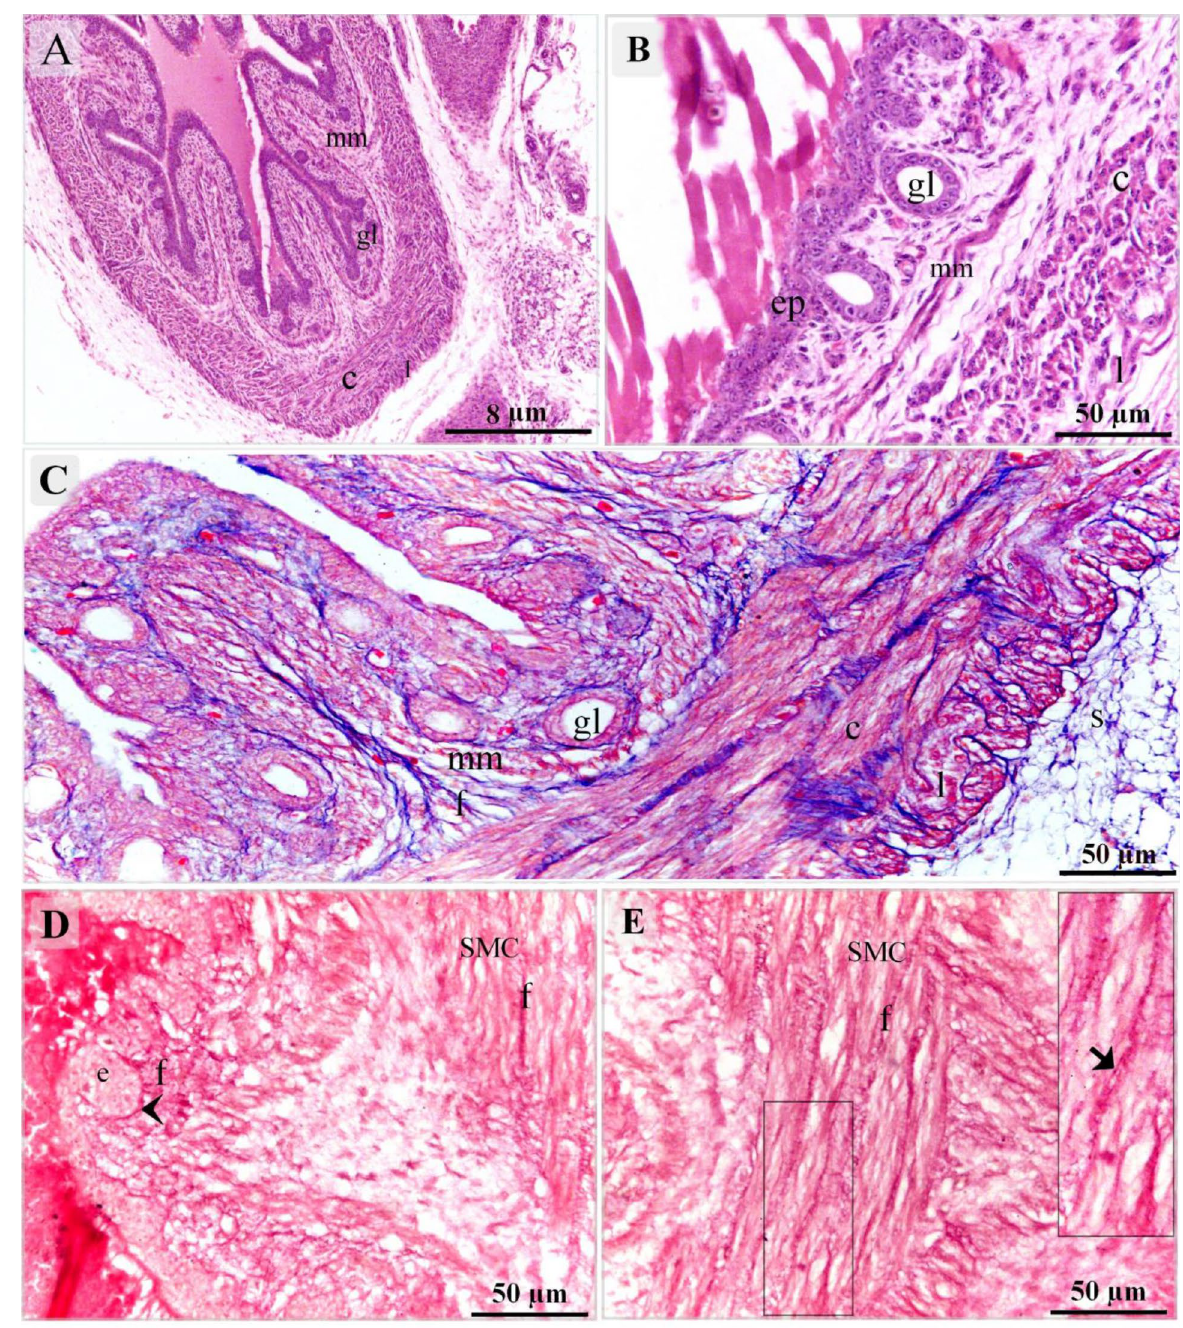
Figure 3. Initiation of glandular development. Cross section of day 13 of quail embryo stained with H&E ( A , B ), Mallory trichrome stain ( C ), Weigert-Van Gieson stain ( D , E ). ( A ) Invagination of the sac-like glandular units (gl), thickening of the inner circular (c) and outer longitudinal (l) muscular layers, muscularis mucosae (mm). ( B ) Esophagus lined by pseudostratified epithelium (ep), the sac-like glandular units (gl), the inner circular (c) and outer longitudinal (l) muscular layers, muscularis mucosae (mm). ( C ) The esophagus had a distinct muscular layer; The inner circular (c) and outer longitudinal (l) muscular layers. Collagen fibers (f). Note muscularis mucosae (mm), serosa (s) gland (gl). ( D , E ) Collagen fiber-rich (f) connective tissues were located under the epithelium (e) and between the muscle bundles (SMC). Collagen fibers located in the basal lamina (arrowhead). Note telocytes